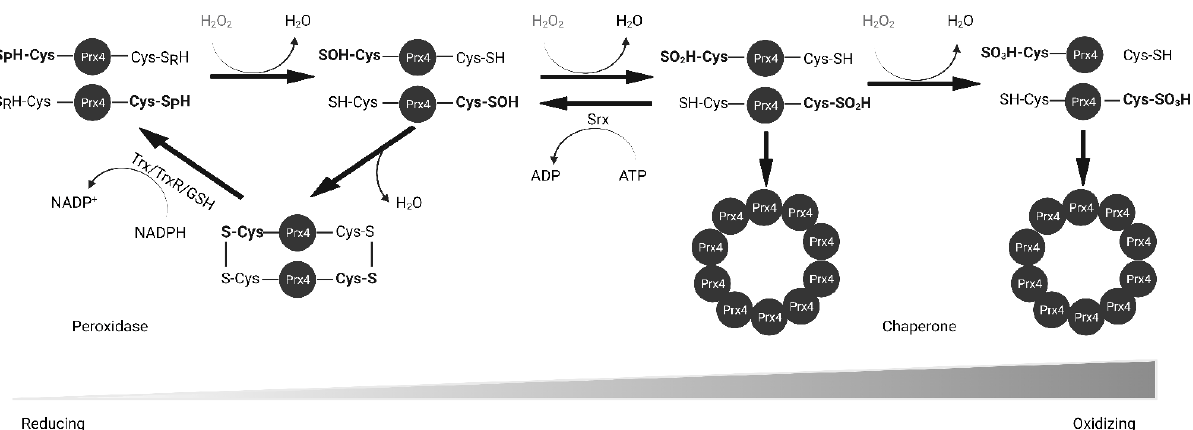
Figure 3. Reduction of H 2 O 2 by Prx4. Peroxidatic cysteine (Cys-SpH) is oxidized to sulfenic acid and either resolved and recycled with the help of Trx or GSH, or further oxidized into sulfinic and sulfonic acid forms. Srx reduces sulfinic acid. Prx4 loses peroxidase activity and gains chaperone activity with increasing oxidizing environment. Trx, thioredoxin; TrxR, thioredoxin reductase; GSH, glutathione; Srx, sulfiredoxin.